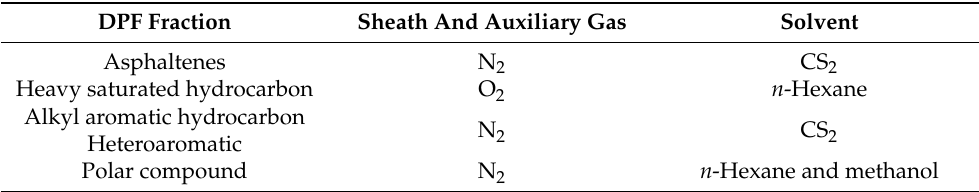
Table 3. Sheath and auxiliary gas and solvents used for the analysis of DPF fractions by positive ion APCI